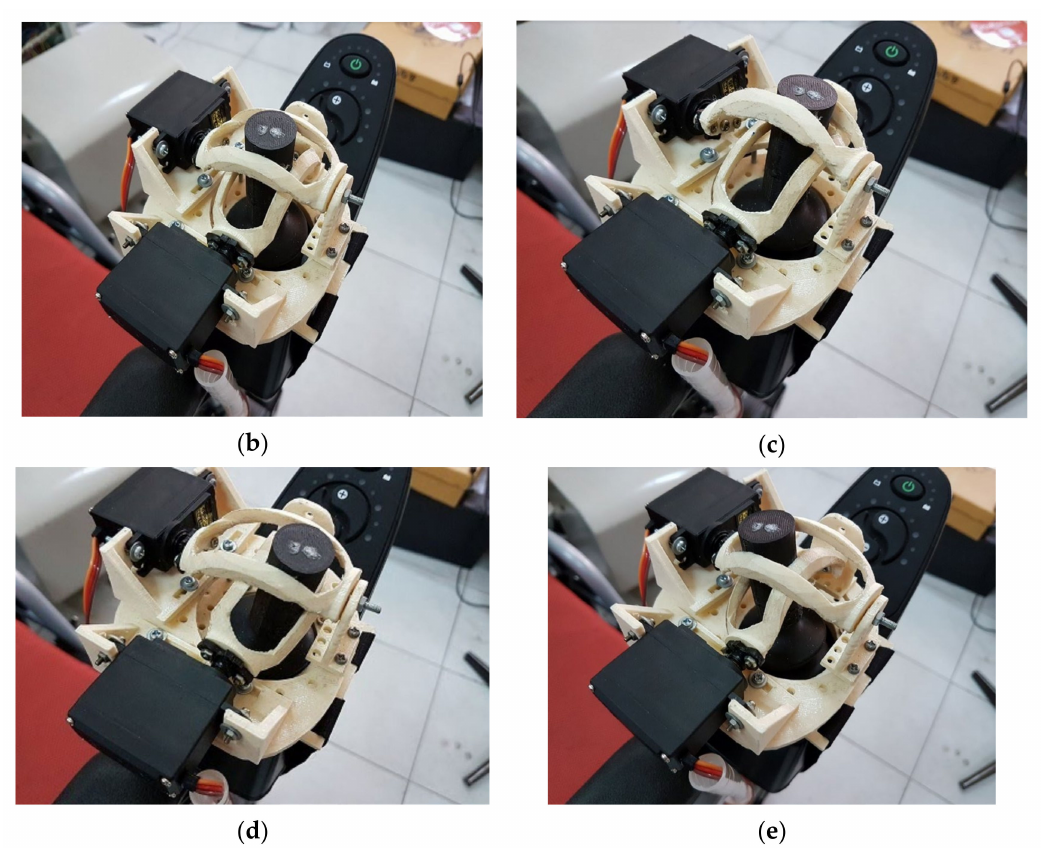
Figure 11. Joystick servo motor coupling unit: ( a ) design, ( b ) stop, ( c ) forward, ( d ) turning right, and ( e ) turning left